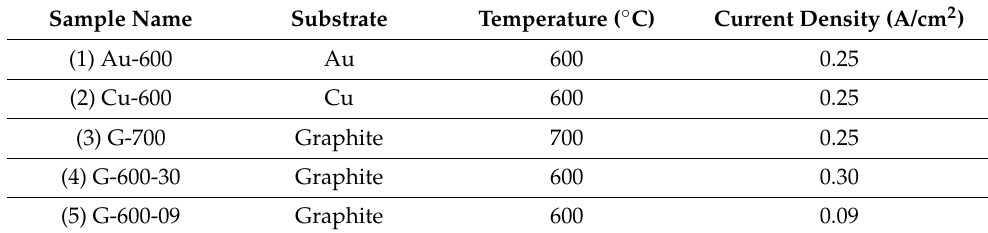
Table 1. Matrix of growth conditions for all